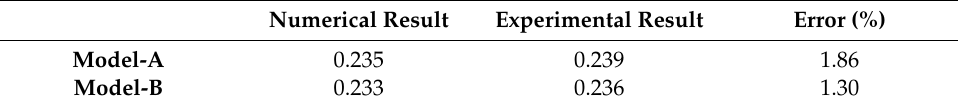
Table 5. Comparison of predicted thrust coe ffi cients with measured ones.